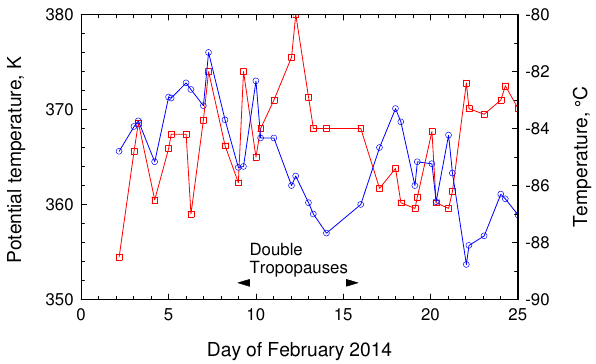
Figure 9. Variation of cold point tropopause temperature (red curve, right axis) and cold point potential temperature (blue curve, left axis) measured by the CAST sondes. Where double tropopauses were observed (between 9 and 16 Feb), the local temperature mini- mum corresponding to a steep increase in ozone concentration was taken as the tropopause. In these cases the coldest point lay around 1–2km